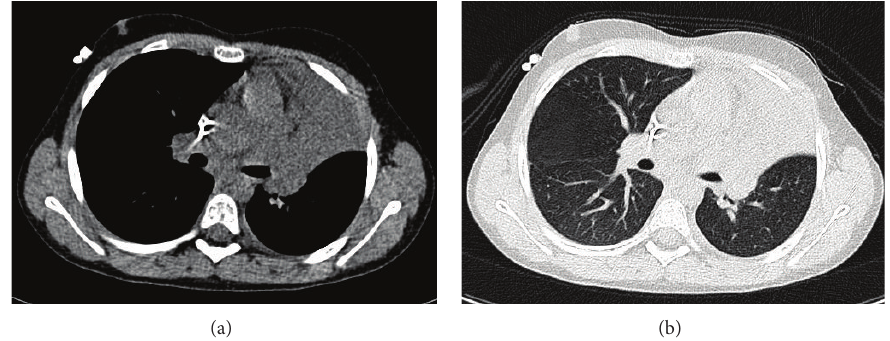
Figure 4: CT scan images of the chest performed on day 9 after transplant. (a) demonstrates complete collapse of the left upper lobe with abrupt cut-off of the left upper lobe bronchus and (b) absence of air bronchograms within the collapsed